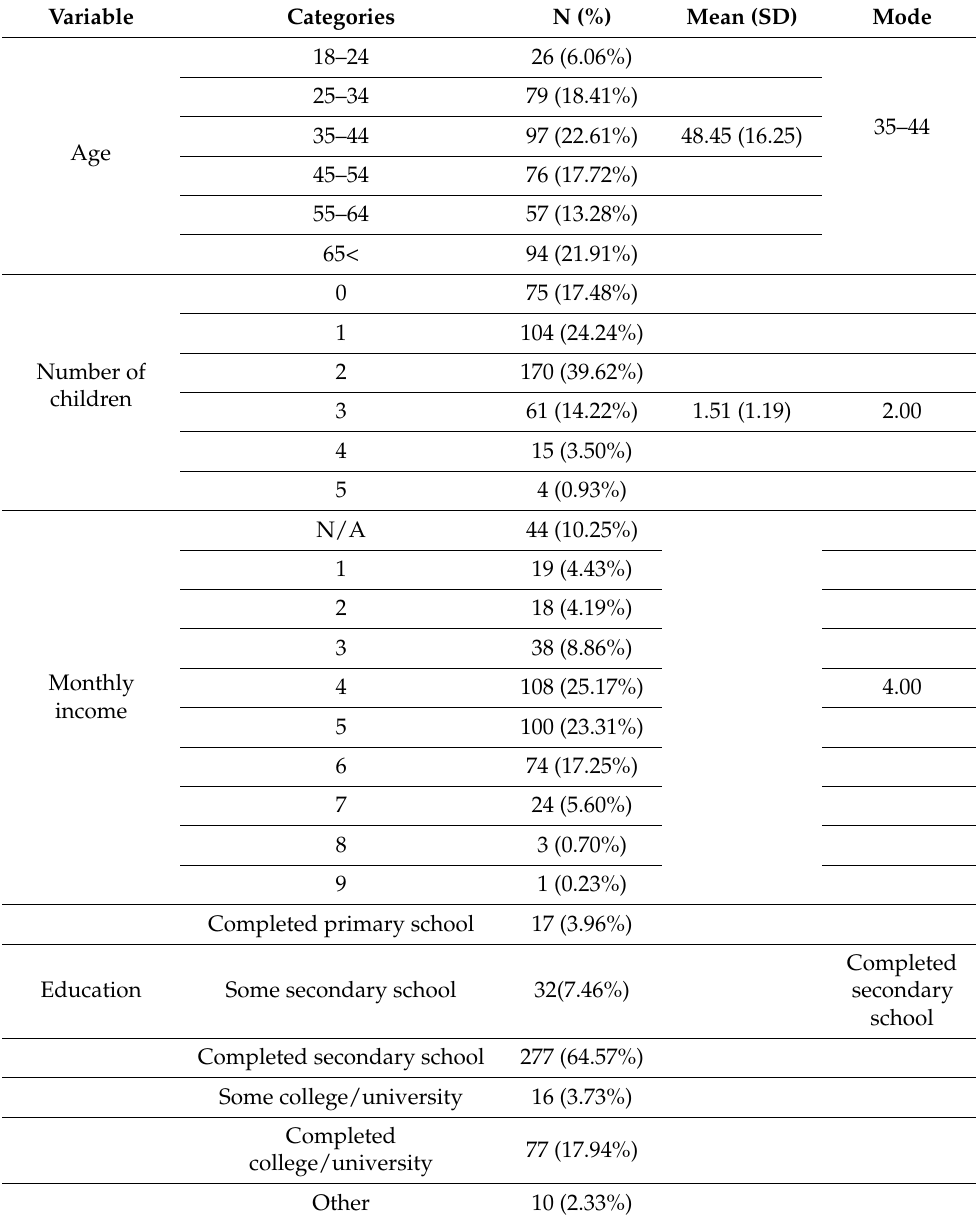
Table 1. Descriptive analysis of sociodemographic variables.